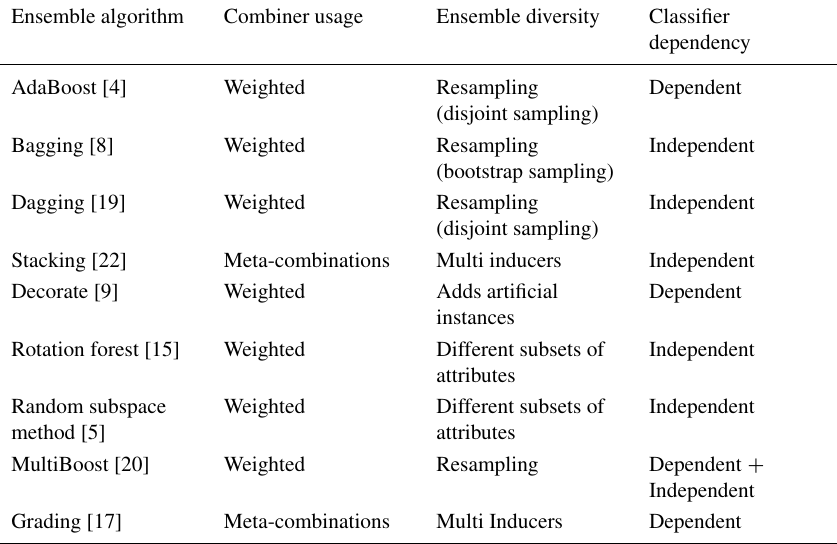
Table 1. Ensemble taxonomy of the nine ensembles method experimented for cate- gorization of diabetic